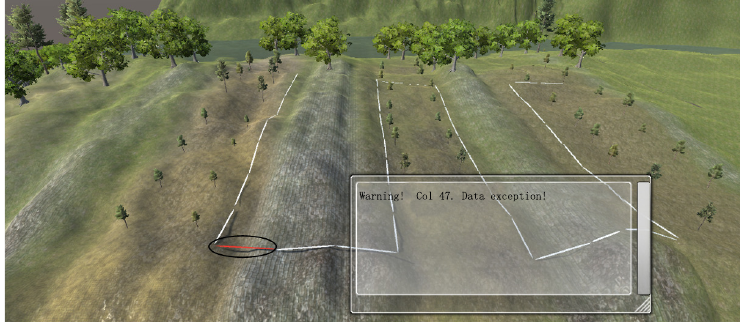
Figure 9. Vibration source alarm after using the isolation